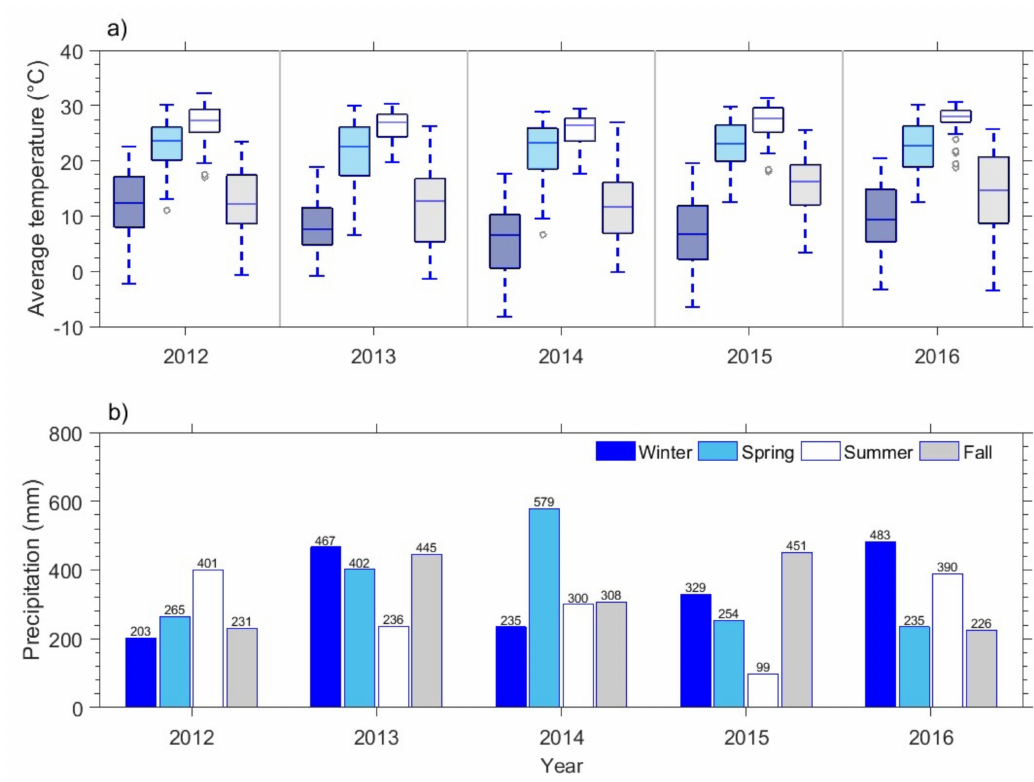
Figure 2. Average temperature and total precipitation by season during the period 2012–2016 at the study site. ( a ) Boxplots of the average temperature. ( b ) Bar chart showing the total precipitation. Winter: January–March; Spring: April–June; Summer: July–September; Fall: October–December. Boxplots were set at 90th (the upper whisker), 75th (the upper quartile), 50th (the median), 25th (the lower quartile), and 10th (the lower whisker) percentiles. Outliers were considered those observations 1.5 times beyond the 25th and 75th percentile and are shown as grey